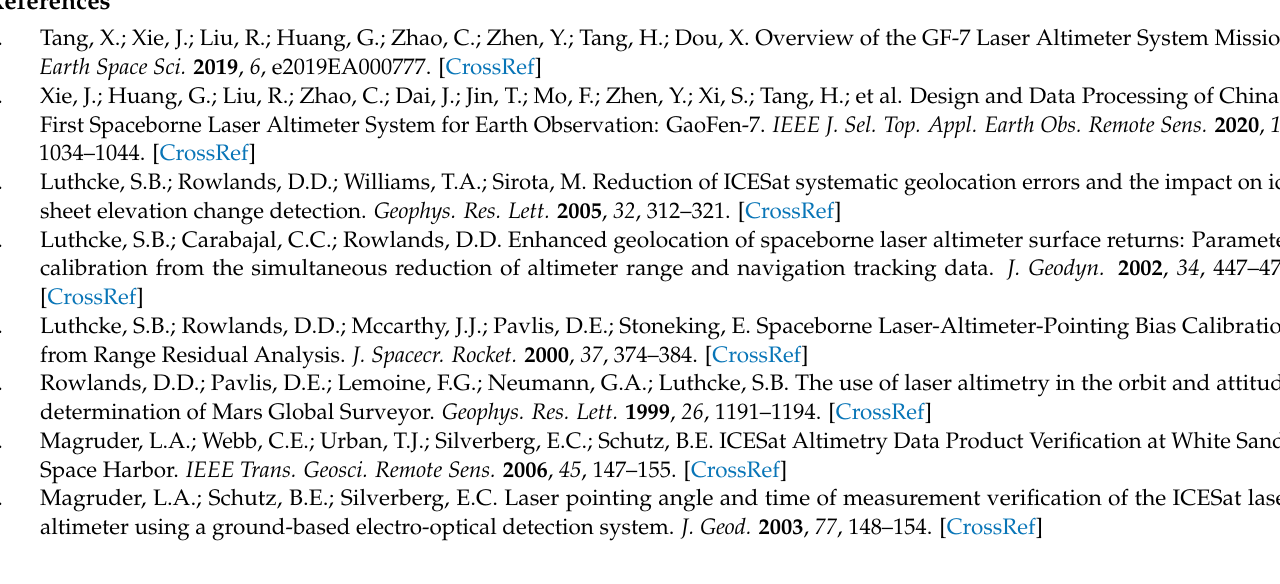
Figure A1. GF-7 satellite laser data query web Figure A1. GF ‐ 7 satellite laser data query web page.